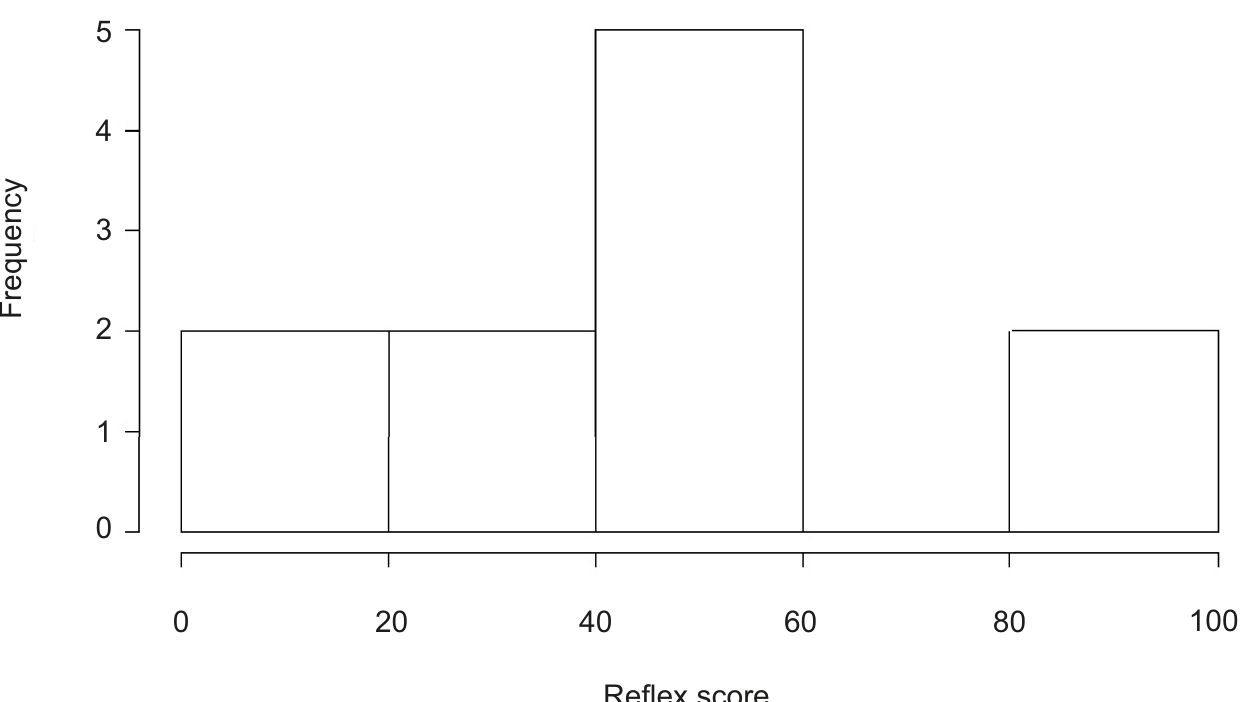
Fig 3. Frequency distribution of average ‘silver standard’ reflex scores. Scores by three expert raters who developed the reflex scoring methodology and were experienced raters were considered as the ‘silver standard’. These three raters scored all original clips (N = 12) that went into the making of the scoring video for sessions